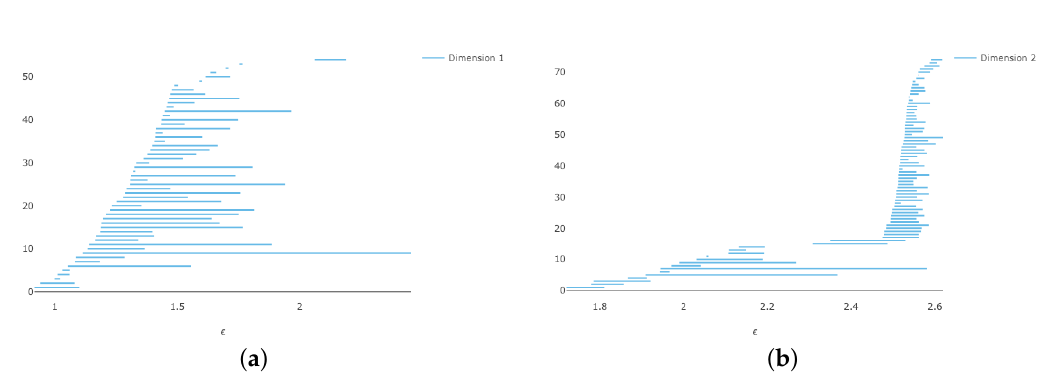
Figure 7. Vietoris–Rips persistence diagrams for 100 points on R P 3 , realizing it as the Lie group SO ( 3 ) ⊂ R 9 ( a ) H 1 persistence and ( b ) H 2